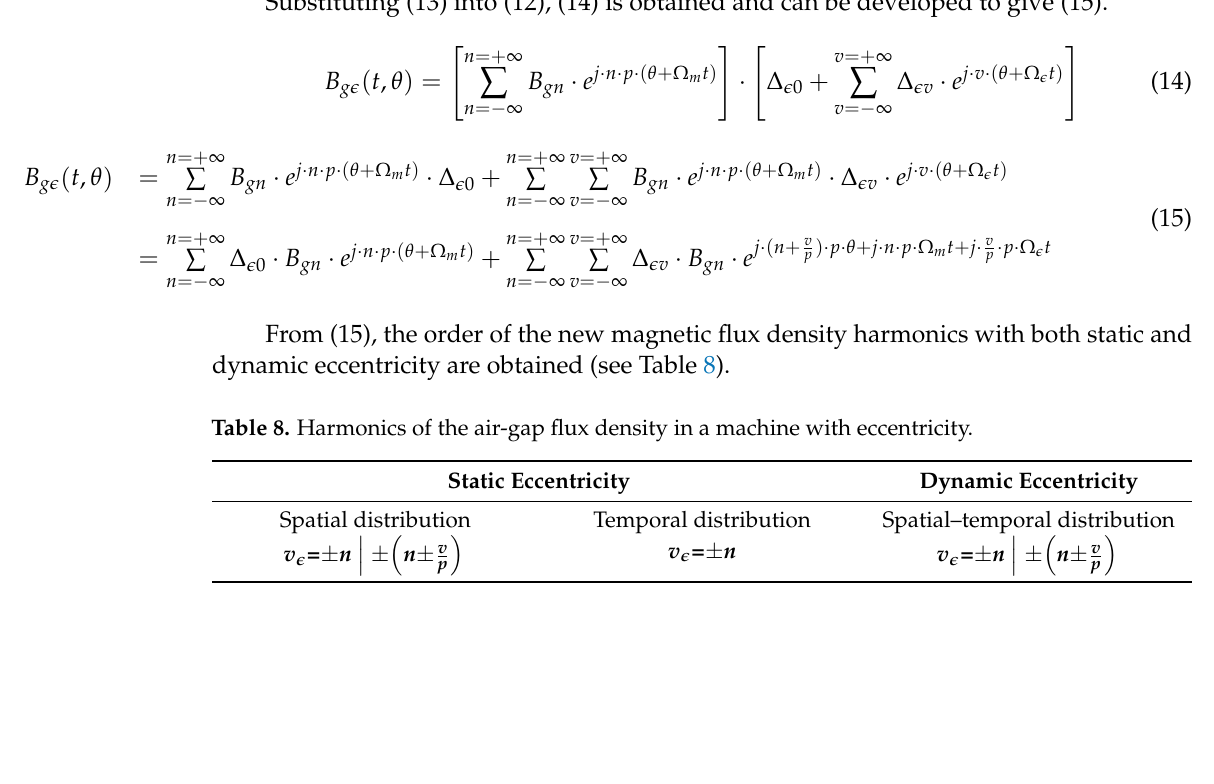
Table 8. Harmonics of the air-gap flux density in a machine with eccentricity.